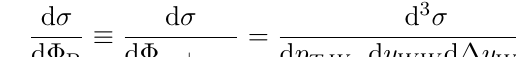
Figure 3 . Same as (cid:12)gure 2, but for the CS angles of the W + decay: (a) (cid:18) CS NNLOPS and NNLO, which demonstrates the validity of our procedure to describe the W decays via CS angles. In fact, we have checked explicitly at NNLO level that eq. (2.13) reproduces the correct cross section when being di(cid:11)erential in any two of the four CS angles at the same